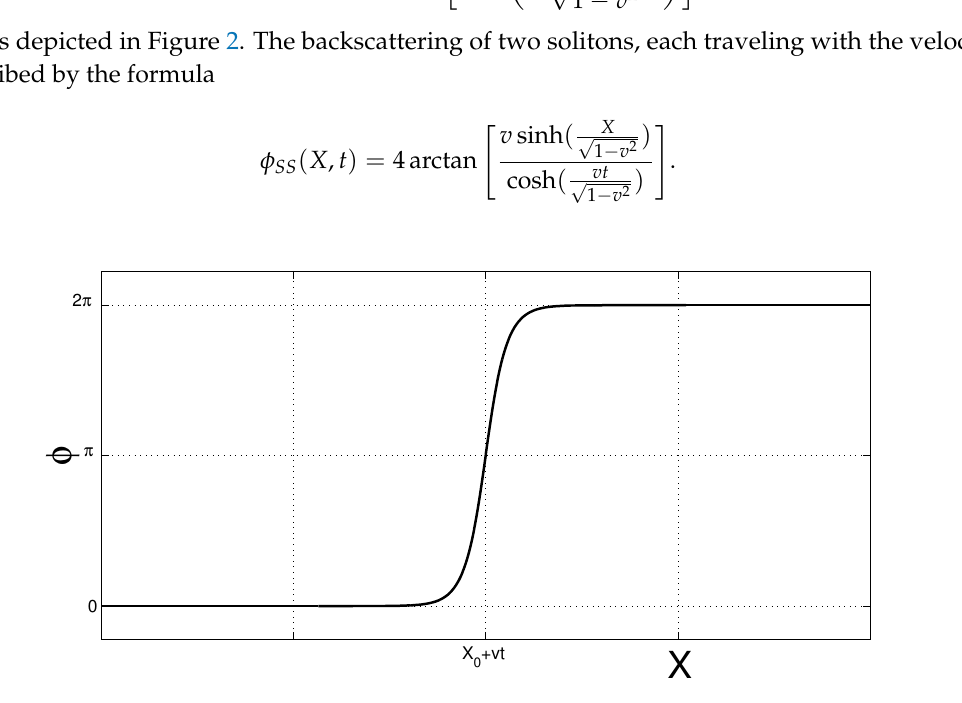
Figure 2. The single soliton solution of the Sine–Gordon